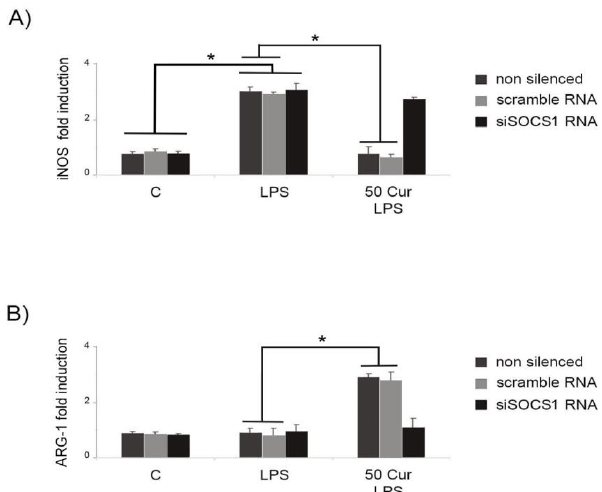
Figure 4. Effect of SOCS-1 downregulation on microglial polarization, determined by RT-PCR. Microglial cells were transfected with either control siRNA (scramble RNA) or SOCS-1 specific siRNA (siSOCS1 RNA). Untransfected cells were used as control. BV-2 microglial cells were incubated for 6 h with LPS alone, or after 1 h of pre-treatment with curcumin (50 µ M). ( A ) M1-like (iNOS) expression marker. ( B ) M2-like (ARG-1) expression marker. Experiments were performed in triplicate, and data are expressed as the mean ± SD of five independent experiments. * p < 0.05. Biology 2019 , 8 , x FOR PEER REVIEW